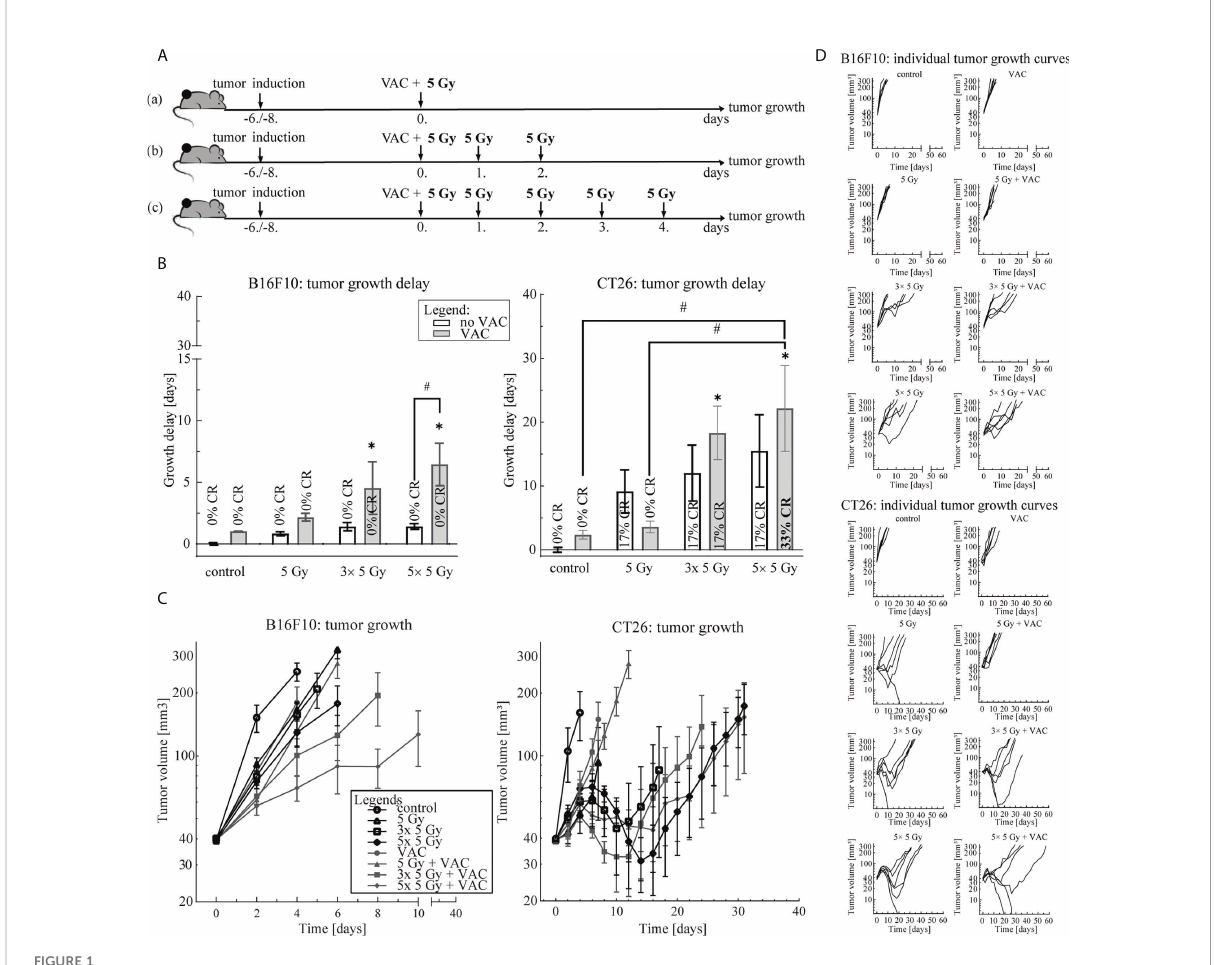
FIGURE 1 Irradiation regimen selection. (A) Treatment timelines: (a) single-dose vaccination combined with 1× 5 Gy, (b) single-dose vaccination combined with 3× 5 Gy and (c) single-dose vaccination combined with 5× 5 Gy. (B) Tumor growth delay in the B16F10 (left) and the CT26 (right) tumor model. The legend applies to both graphs. (C) Tumor growth over time in the B16F10 (left) and the CT26 tumor model. The legend applies to both graphs. (D) Individual growth curves for each tumor of each treatment (control) group in the B16F10 (top) and the CT26 (bottom) tumor model. Legend: *p < 0.05 versus control group; # p < 0.05 between the annotated treatment groups; CR, complete response; VAC, single-dose